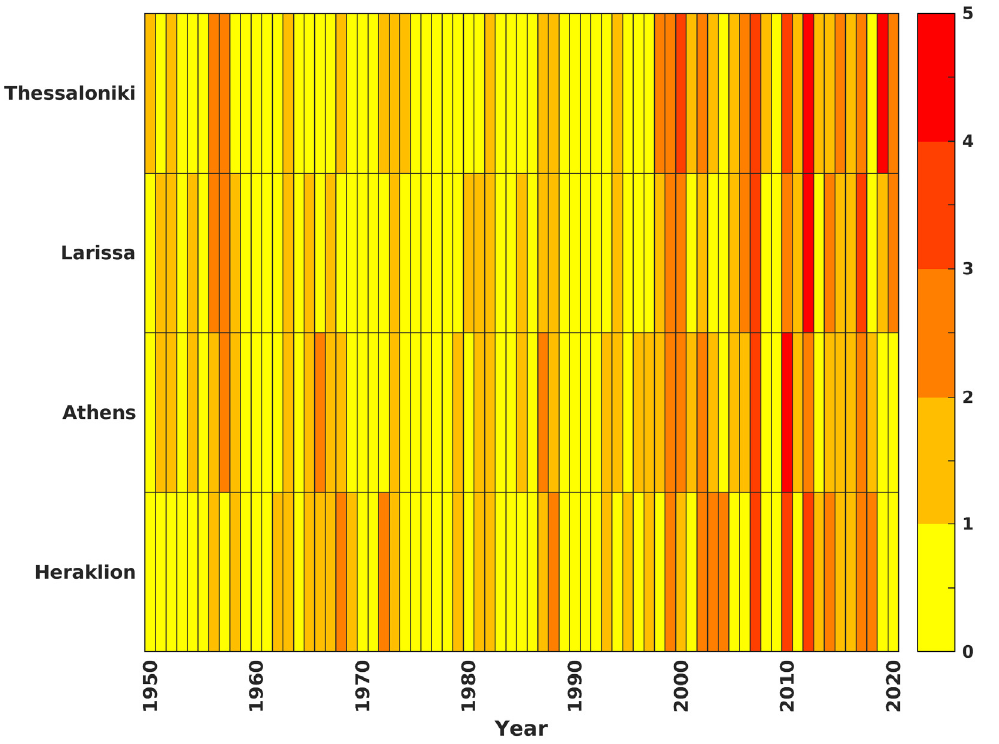
Figure 13. Heatmap of the temporal evolution of HWN (heatwaves) for selected cities calculated from ERA5-Land during the period 1950–2020. The color bar indicates the number of heatwaves per